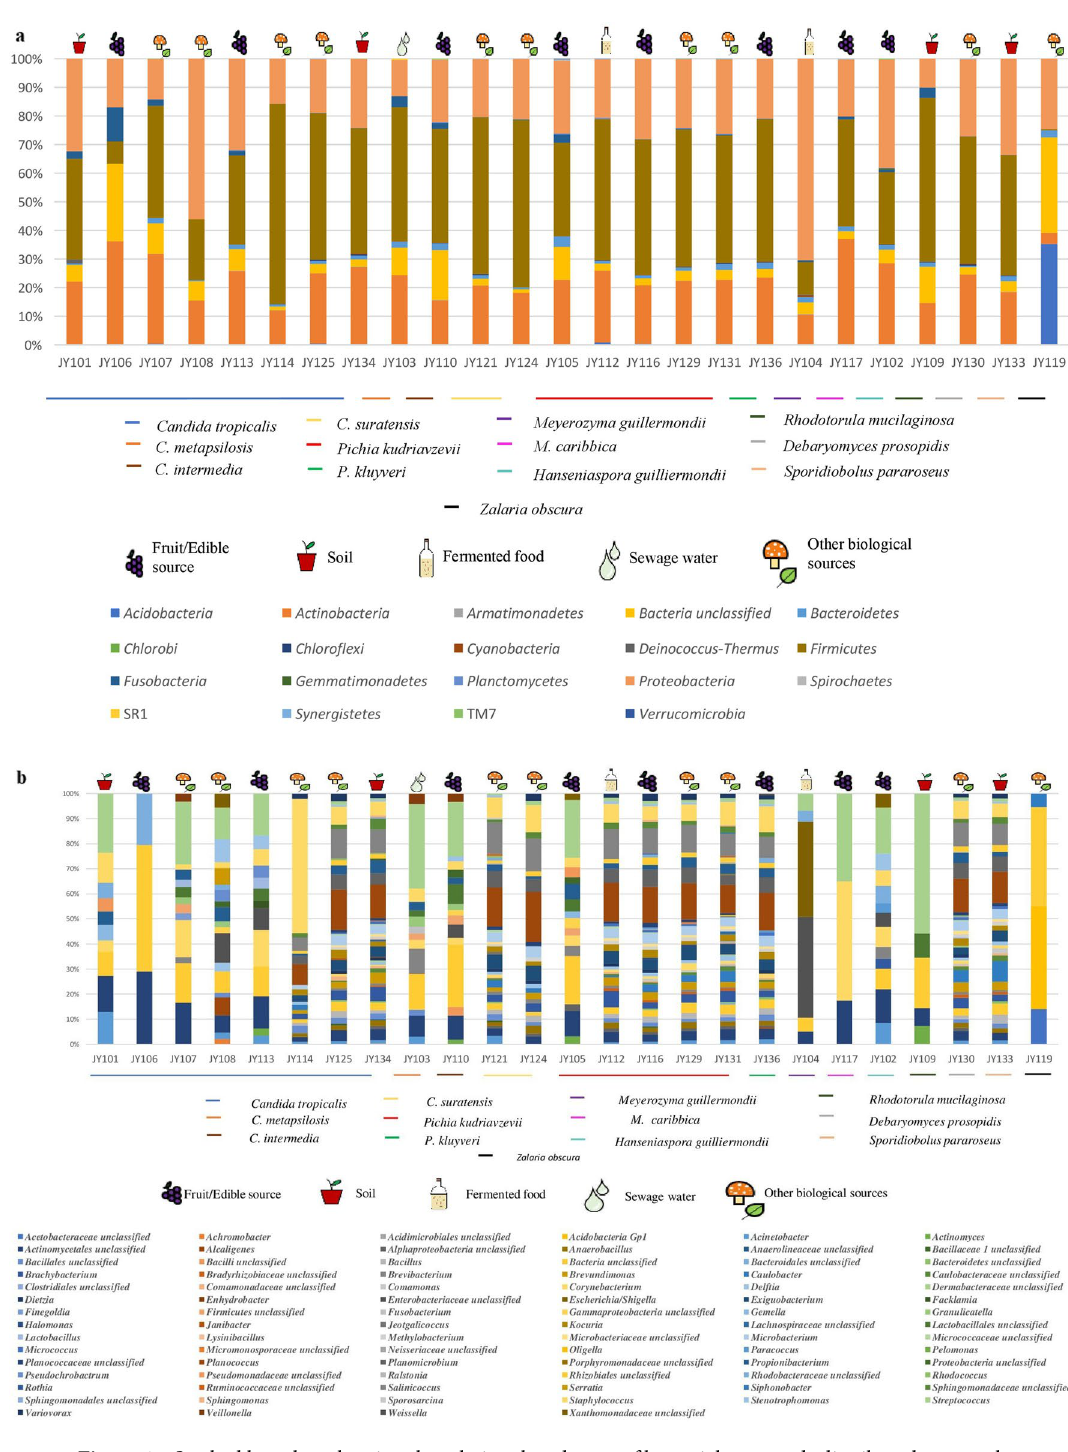
Figure 1. Stacked bar plots showing the relative abundances of bacterial taxa reads distributed among the twenty-five yeast strains; ( a ), taxa at phylum level; ( b ), bacteria at genus level. X-axis indicates yeast strains and Y-axis indicates the relative abundance of bacterial taxa calculated as percentage of Operational Taxonomic Units (OTUs). The plots are supported with legends showing the yeast strains, bacterial taxa as well as environmental sources of yeast isolation. Data on bacterial taxa reads found in each yeast was obtained using mothur V. 1.41.1 24–26 . Plots were constructed using Microsoft Excel and images are self-made using Microsoft power